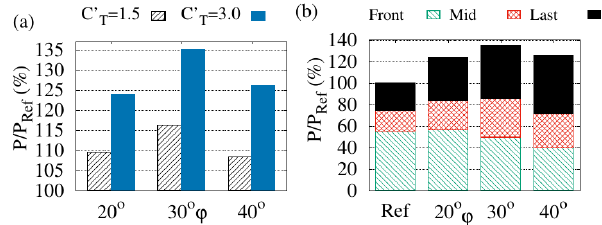
Figure 1. Mean-wind profiles obtained in the precursor simulations along the x axis (a) and the y axis (b) for the simulations with a capping inversion at H = 750, H = 500 and H = 350m. In all cases the flow is forced so as to have U ( z = 100m) = 8m/s, V ( z = 100m) = 0. The logarithmic velocity profile U = ( u ∗ /κ ) ln( z/z 0 ) is also reported for comparison, where u ∗ is the mean friction ve- locity and κ = 0 . 38 is the von Kármán constant. The heights corre- sponding to the maximum vertical extent ( z h + D/ 2) for the turbines considered in the following (with D = 126, D = 180, D = 250 and D = 360m) are also reported for future reference.